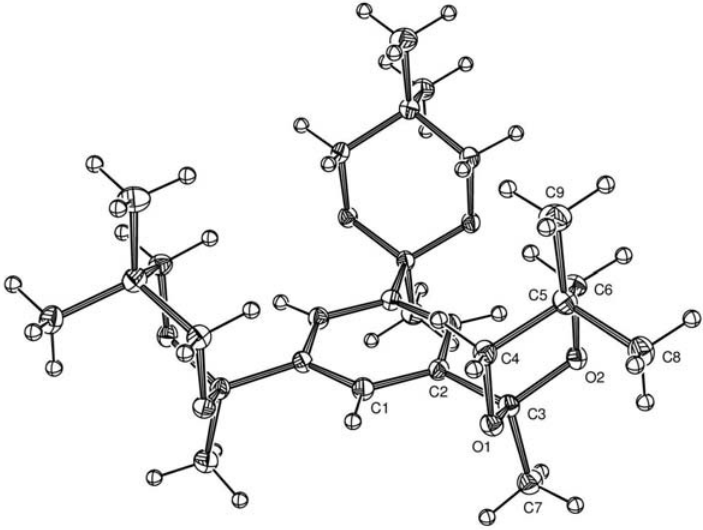
Fig. 1 ORTEP diagram for compd 3